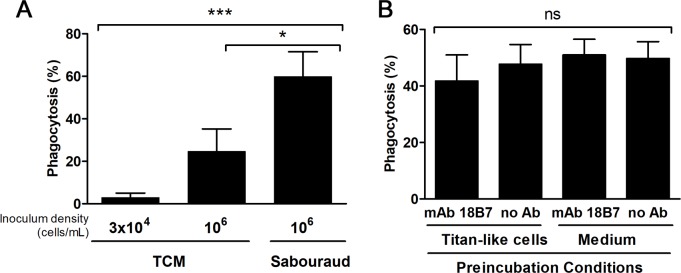
Interaction of titan-like cells with murine-like macrophages.A) Cells from H99-GFP strain were incubated in TCM inoculated at 3x104 cells/mL (titan-like cells), 106 cells/mL (regular cells in TCM), and Sabouraud. Then, phagocytosis experiments with RAW264.7 cells were performed and quantified by flow cytometry as described in material and methods. Statistical differences are highlighted. B) Effect of preincubation of macrophages with titan-like cells on the phagocytosis of regular cells. Titan-like cells were obtained by incubation of C. neoformans in TCM as described in material and methods, and were exposed to RAW264.7 macrophages at 1:1 ratio. The incubation was performed in media containing the opsonizing mAb 18B7 or in its absence. As control, macrophages were preincubated with growth medium with or without the mAb. The plates were incubated for 1h at 37°C in the presence of 5% CO2, and then the cells were washed to remove titan-like cells. Next, C. neoformans cells (H99-GFP) of regular size grown in Sabouraud were added to the macrophages at 1:1 ratio in the presence of mAb 18B7, and phagocytosis was performed for 1 h at 37°C in CO2. Phagocytosis percentage was quantified by flow cytometry as described in M&M. ns: no statistical difference. The experiment was performed in triplicates in three different days.